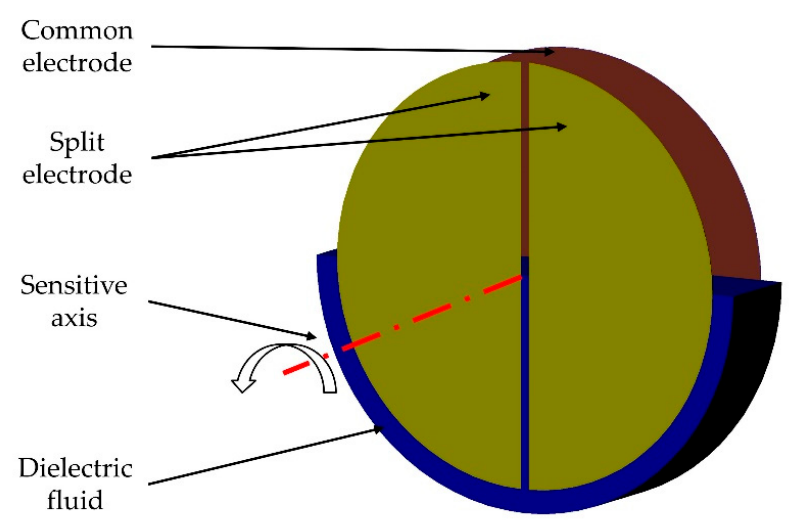
Figure 12. Functional principle with two electrodes in one cavity. The configuration with two electrodes is limited to a measurement range < ± 90 ◦ . To overcome that issue, two sensor elements, which are rotated 90 ◦ against each other, can be used. In this work, this version is called PCB2. Another possibility is to integrate four electrodes in one cavity (PCB1), as shown in Figure 13.